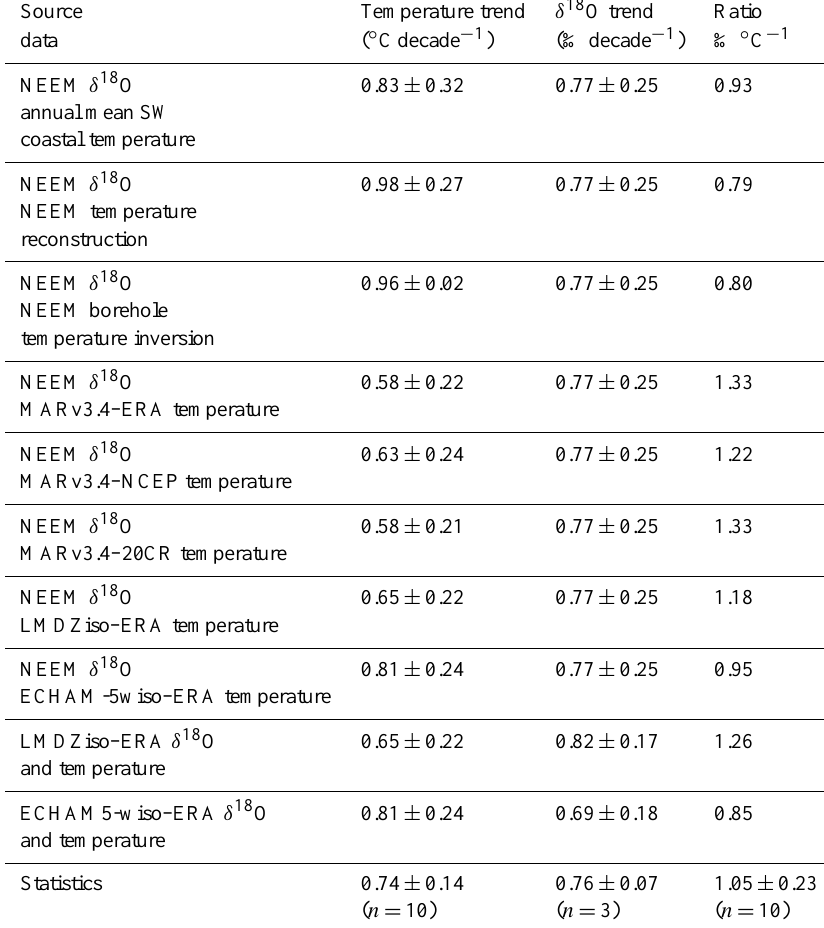
Table 6. Calculations of NEEM – δ 18 O temporal slope for the period 1979–2007 using all sources of information (six temperature estimates and three δ 18 O estimates). For each data source, the slope is calculated based on the ratio of the multidecadal trends for δ 18 O and for temperature. The reported statistics are the mean and standard deviation of trends and slopes calculated for all listed source data sets. Here, NEEM temperature reconstruction refers to the data set of Box et al.